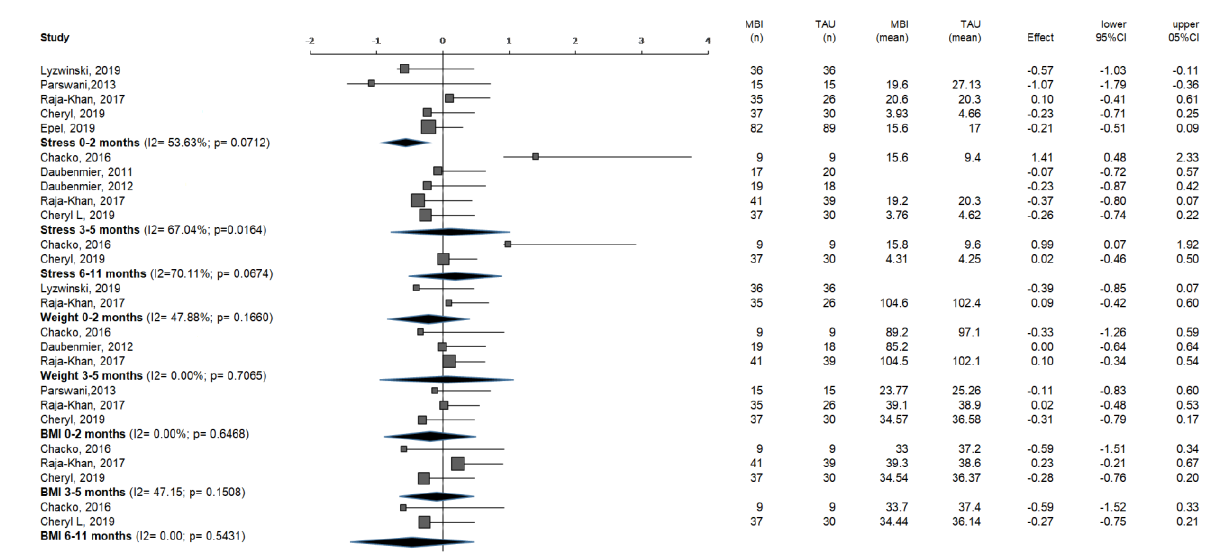
Figure 4. Meta-analysis of mindfulness-based interventions ([10,13,24,26,31 – 33,35]). Horizontal axis represents effect size (standardized mean difference); I2, heterogeneity coefficient; p , significance for Q-statistic; MBI, mindfulness-based intervention; TAU, therapy as usual.